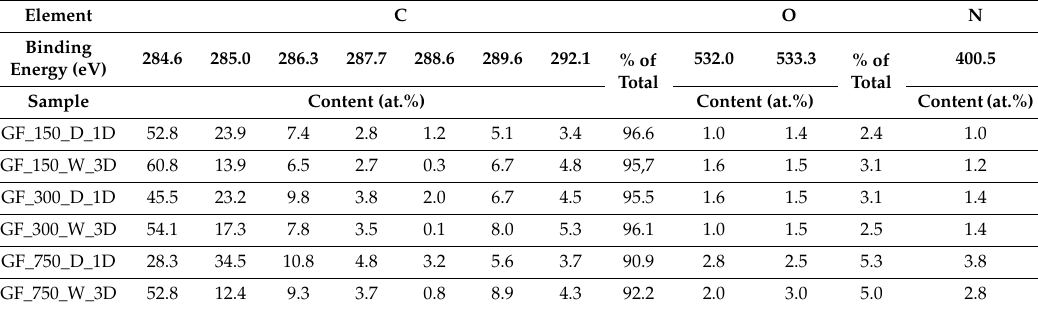
Figure 5. High-resolution X-ray photoelectron spectra for C1s, N1s, and O1s of representative samples: ( a ) C1s of GF_750_D_1D, ( b ) O1s of GF_750_D_1D, ( c ) N1s of GF_750_D_1D, ( d ) C1s of GF_750_W_3D, ( e ) O1s of GF_750_W_3D and ( f ) N1s of GF_750_W_3D. Table 4. Elemental composition of the obtained N-doped graphene from the XPS spectra.